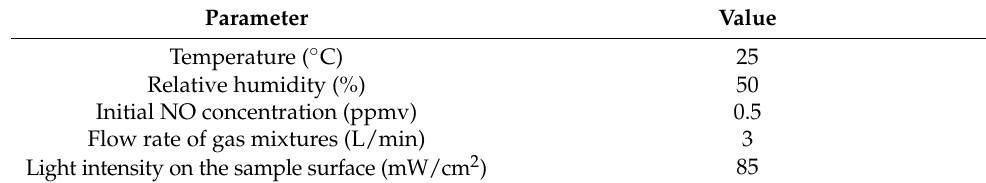
Table 5. Photocatalytic experimental